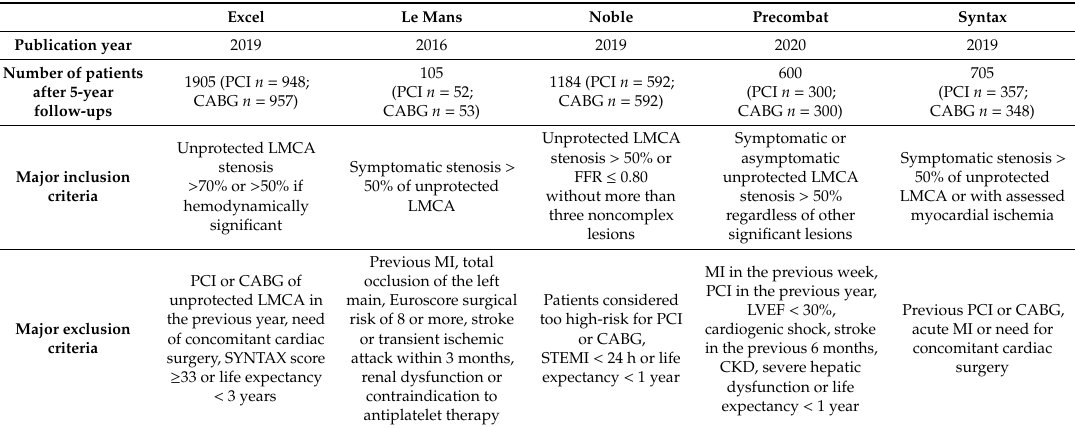
Table 1. Trials characteristics.